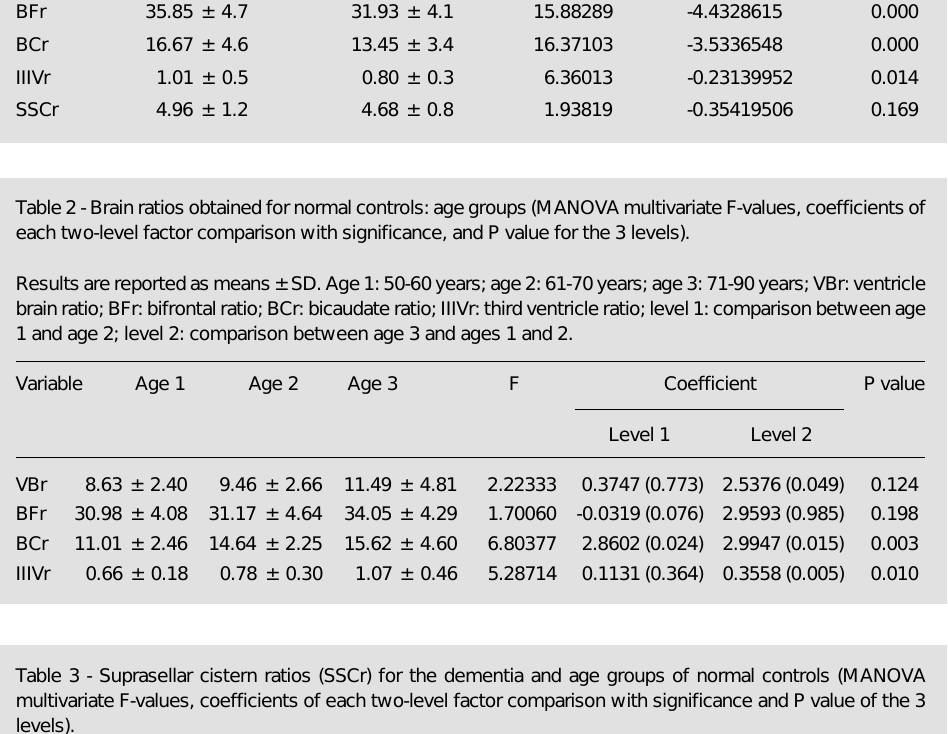
Table 3 - Suprasellar cistern ratios (SSCr) for the dementia and age groups of normal controls (MANOVA multivariate F-values, coefficients of each two-level factor comparison with significance and P value of the 3